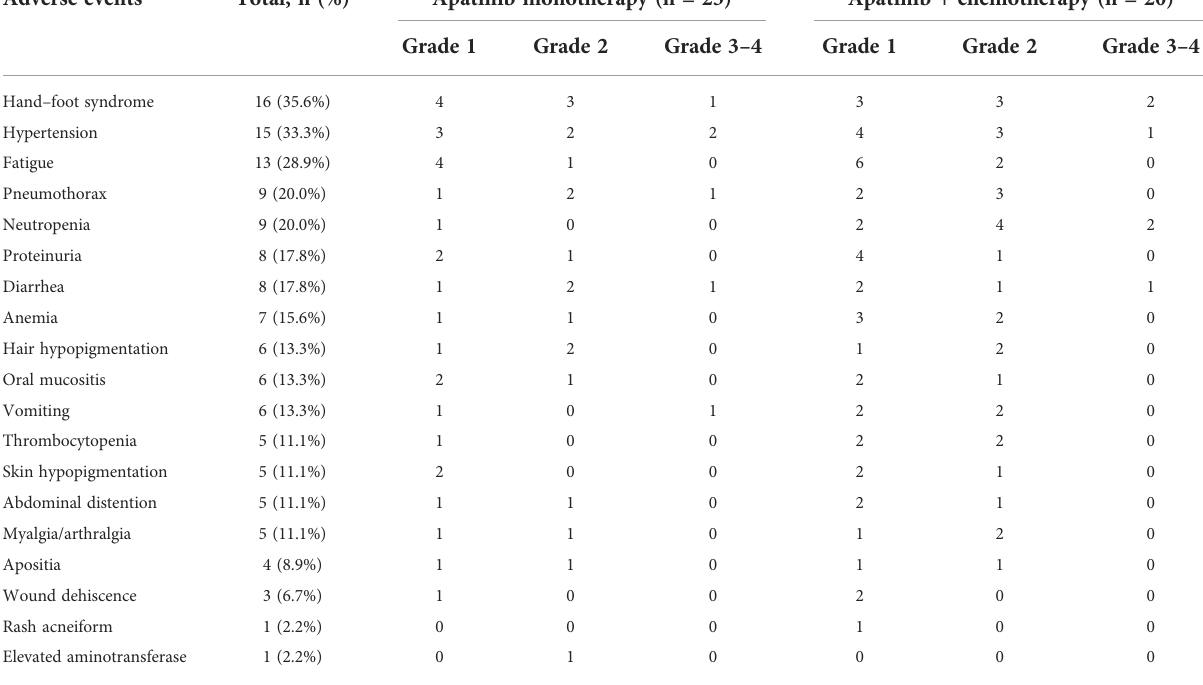
TABLE 3 Treatment-related adverse events that occurred during apatinib